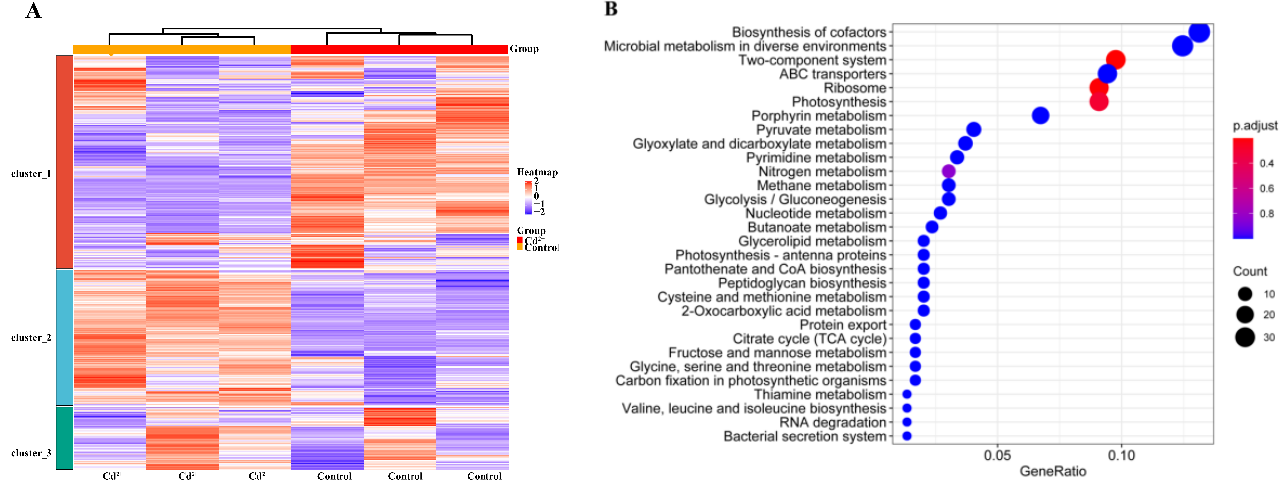
Figure 5. ( A ) Heat map of abundance distribution expressed by DEGs. ( B ) Dot plots of DEGs enrichment analysis by KEGG.